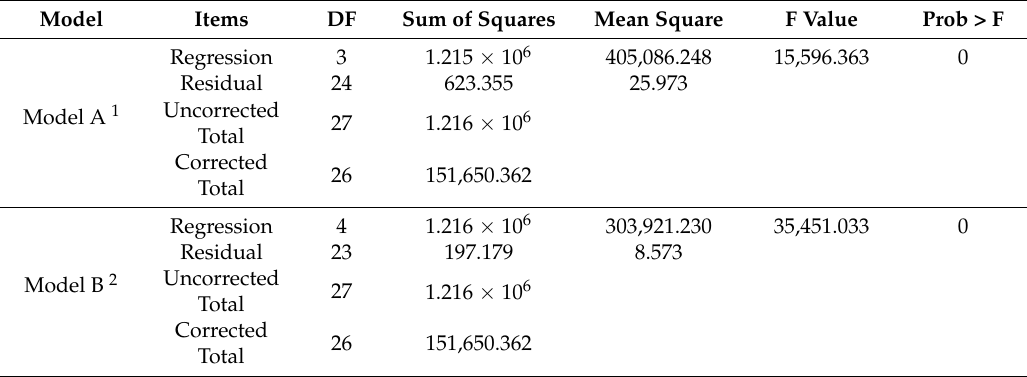
Table 6. ANOVA for material-drilling power of the JTVM6540 CNC milling machine. Model Items DF Sum of